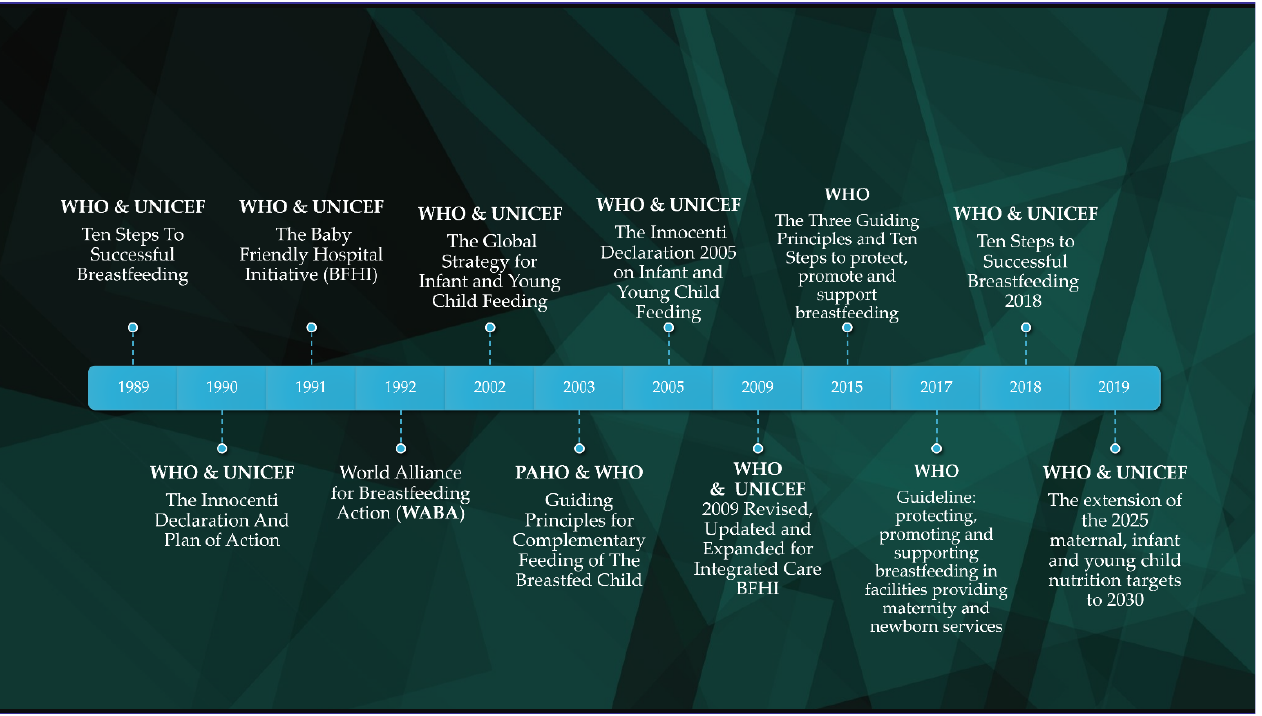
Figure 1. Timeline of the international strategies for improving infant and young child feeding.